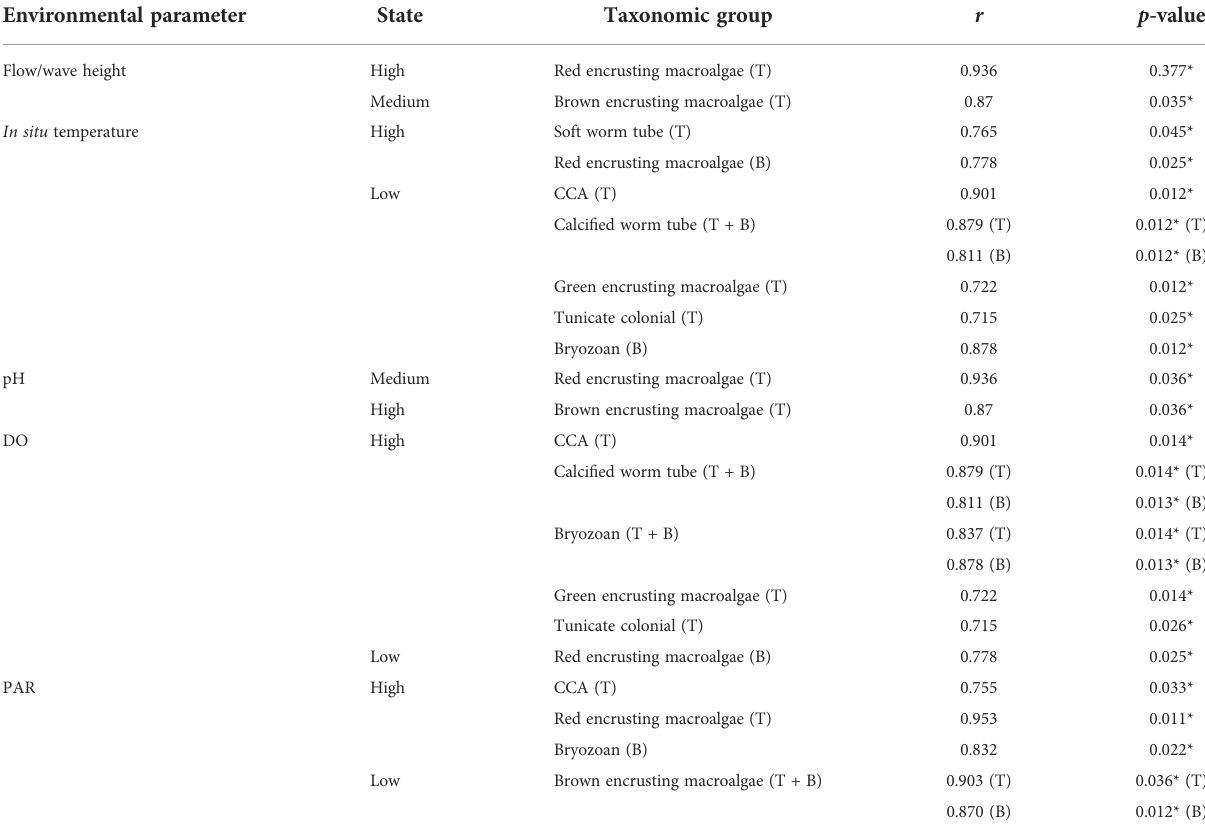
TABLE 3 Results of point biserial correlation analyses of benthic groups with mean environmental parameter values, across either top or bottom plate communities. Environmental